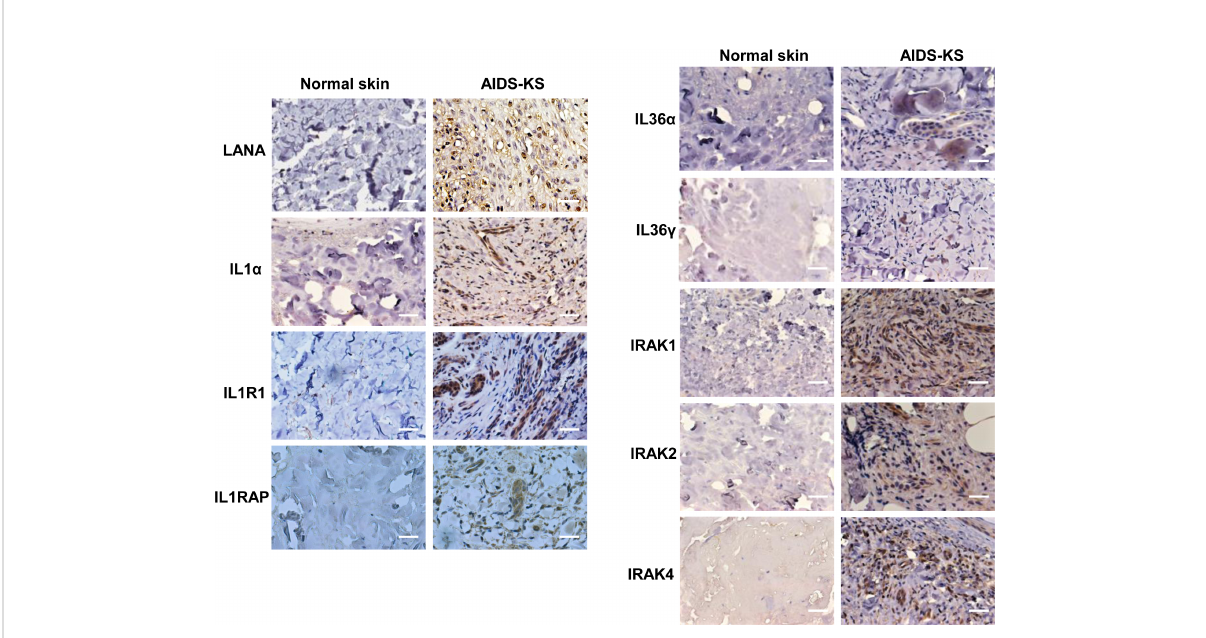
FIGURE 5 The upregulation of IL1 signaling molecules within AIDS-KS tissues. Expression of viral latent protein LANA and host IL1 signaling molecules in formalin- fi xed paraf fi n-embedded KS tissues from cohort HIV+ patient and normal skin tissues were determined and compared by using immunohistochemical staining as described in the Methods (the magni fi cation at x40). Bars: 50 m